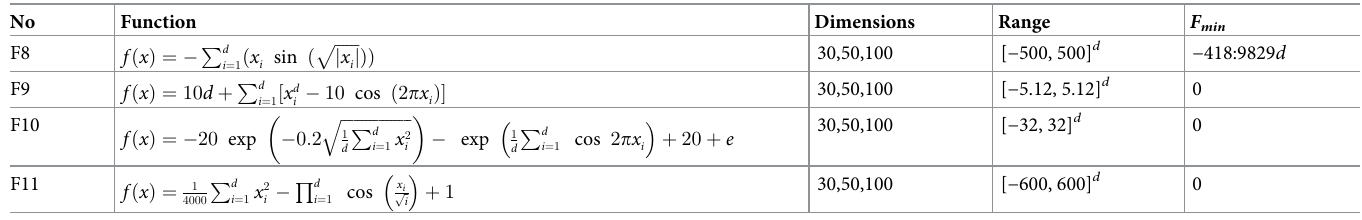
Table 2. Details of multi-modal test functions.